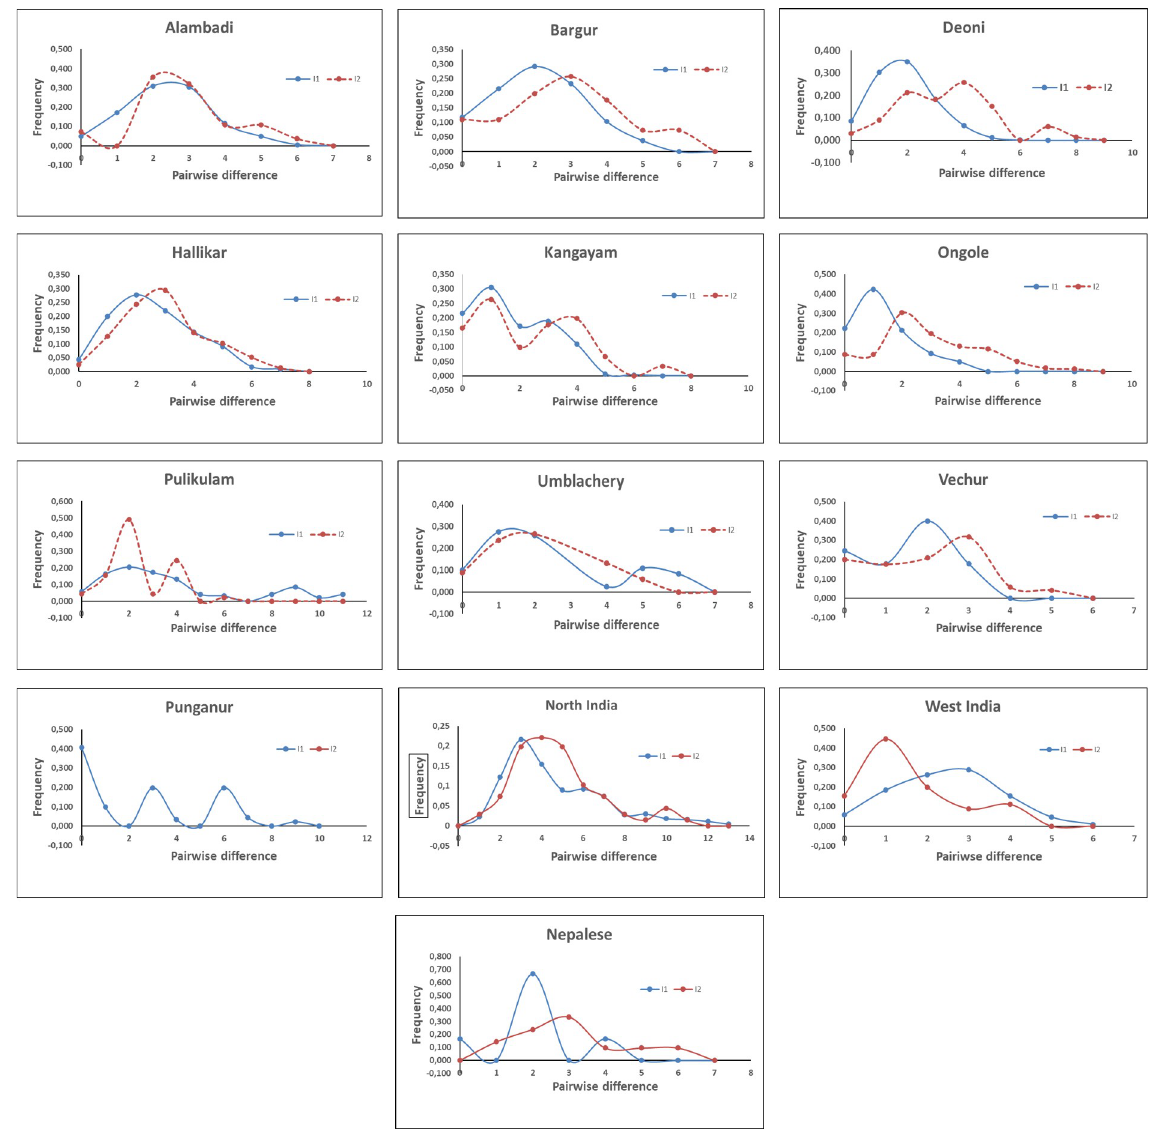
Fig 6. Mismatch distribution of pairwise nucleotide differences among mtDNA control region haplogroups of zebu cattle.